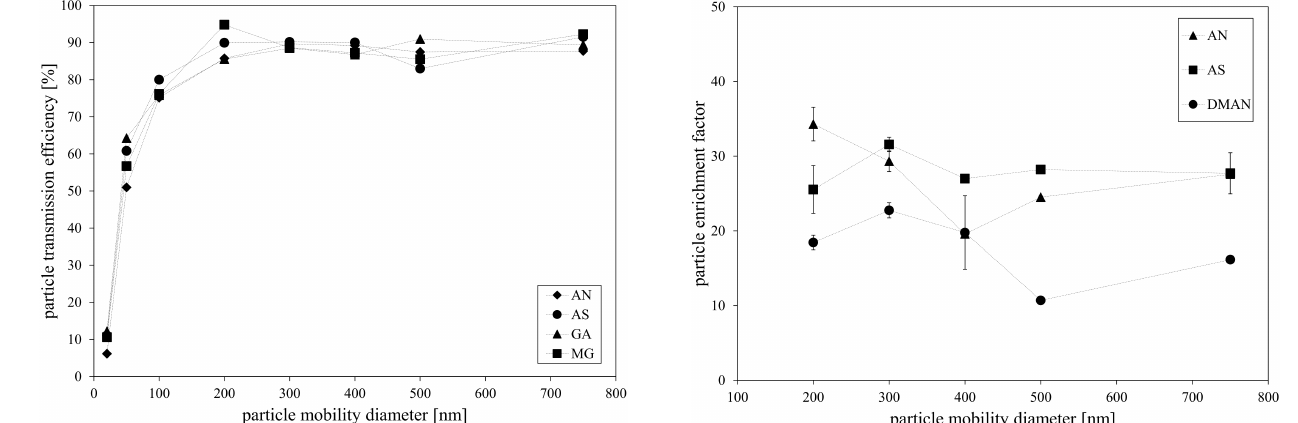
Figure 3. Enrichment factor of the ADL for ammonium nitrate (AN), ammonium sulphate (AS) and dimethylaminium nitrate (DMAN) particles in the 200–750nm size range.